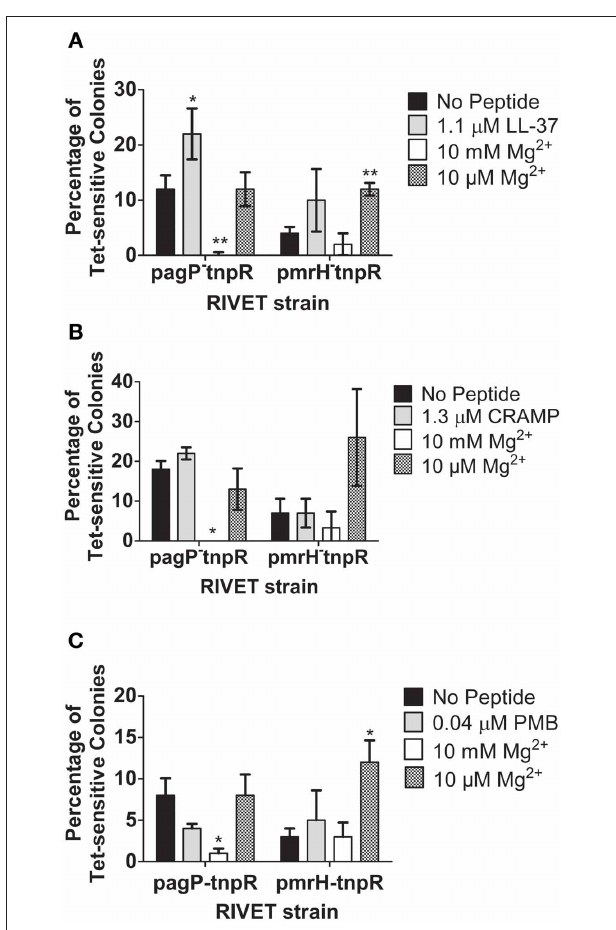
FIGURE 3 | Induction of pagP and pmrH in response to S . Typhimurium TCRS-mediated sensing of LL-37 and magnesium. RIVET strains containing the promoter regions of a PhoP-mediated gene, pagP , or a PmrA-regulated gene, pmrH , were incubated in vitro with (A) LL-37, (B) CRAMP or (C) Polymyxin B and high (10mM) or low (10 μ M) MgCl 2 (Mg 2 + ) for 4h to induce resolvase production. Bacteria were diluted and plated on LB O/N at 37 ◦ C and patched on LB and LB + Tet for detection of Tet-sensitive colonies. The percentage of recovered Tet-sensitive colonies from each sample was averaged for analysis. Graphed values represent the mean ± standard deviation of one representative experiment performed at least twice in triplicate. ∗ Indicates p < 0 . 05; ∗∗ indicates p < 0 .